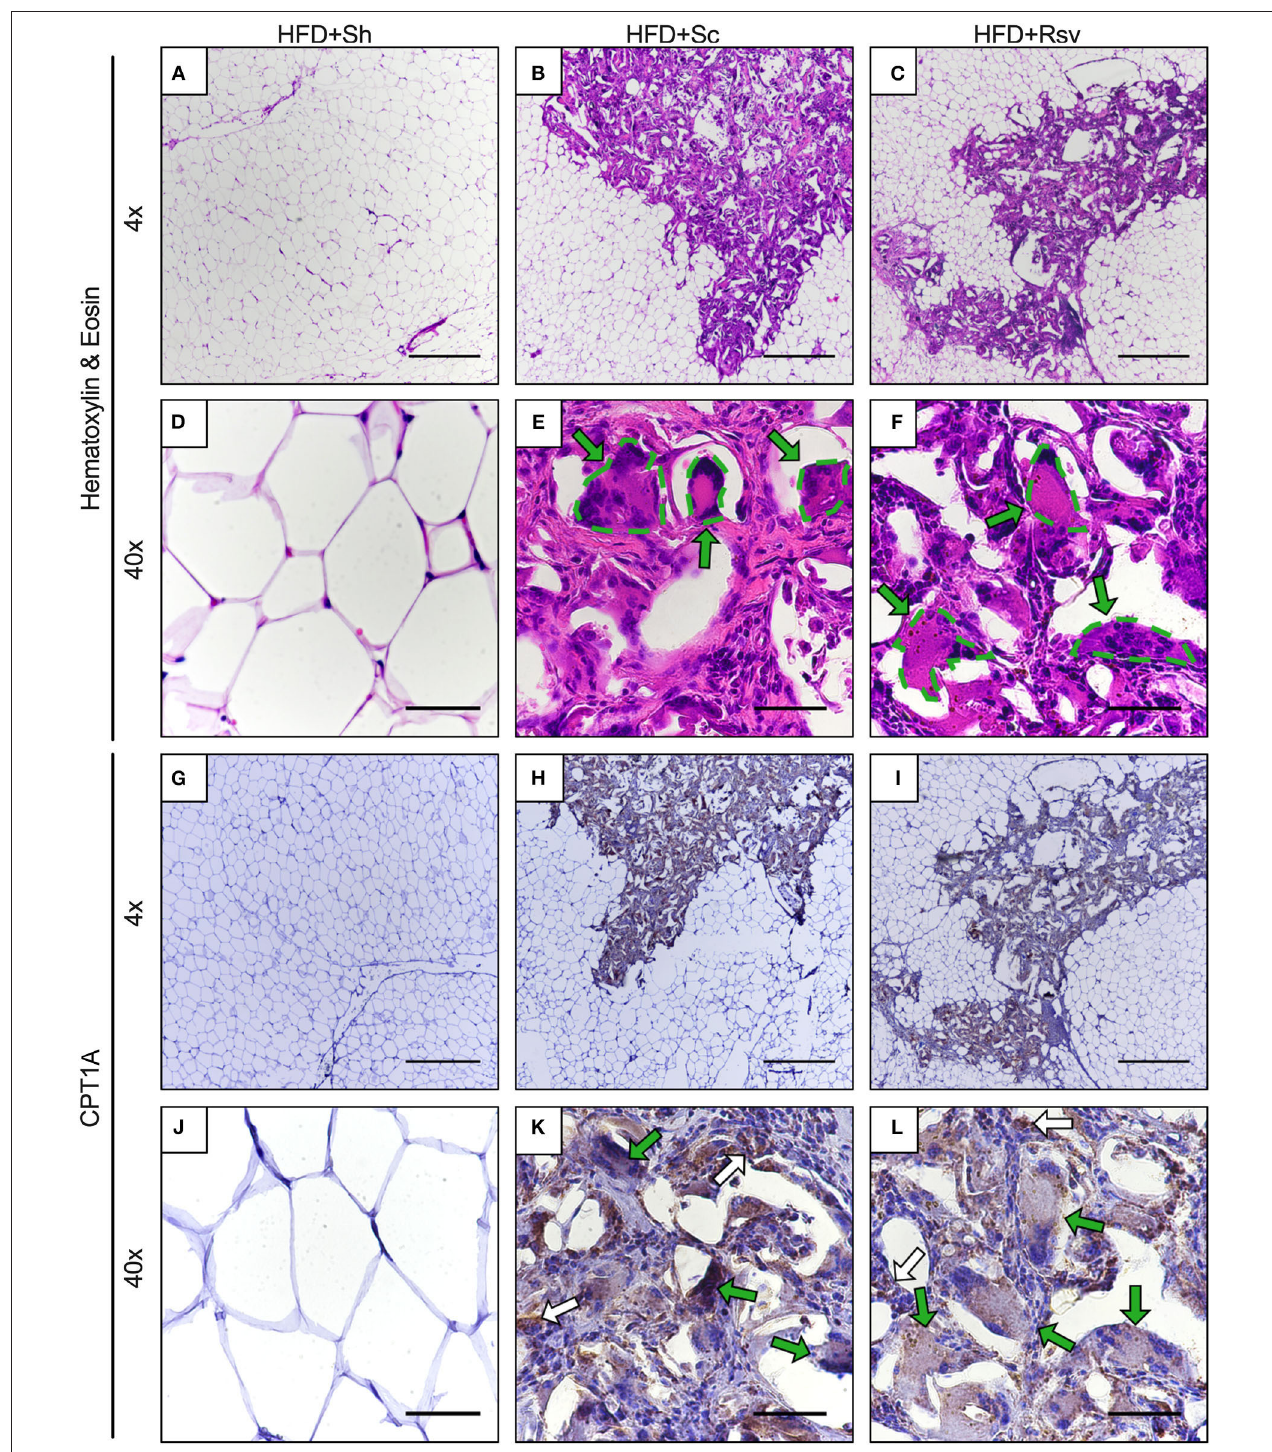
FIGURE 7 | Cellular infiltration and CPT1A expression within epididymal fat pads 2 weeks after scaffold implant. Representative images of epididymal fat sections from high fat diet fed mice receiving sham procedure, blank scaffolds, or resveratrol scaffolds. Sections are from 2 weeks after scaffold implant. (A–F) Hematoxylin and eosin staining. (E,F) Dotted lines encircle multinucleated giant cells. (G–L) Immunohistochemistry for CPT1A. (K,L) Green arrows indicate multinucleated giant cells expressing CPT1A. White arrows indicate non-fused cells expressing CPT1A. Scale bars represent 500 µ m for 4x images and 50 µ m for 40x images. Data is a representative of 3 mice per condition and 3 separate sections per